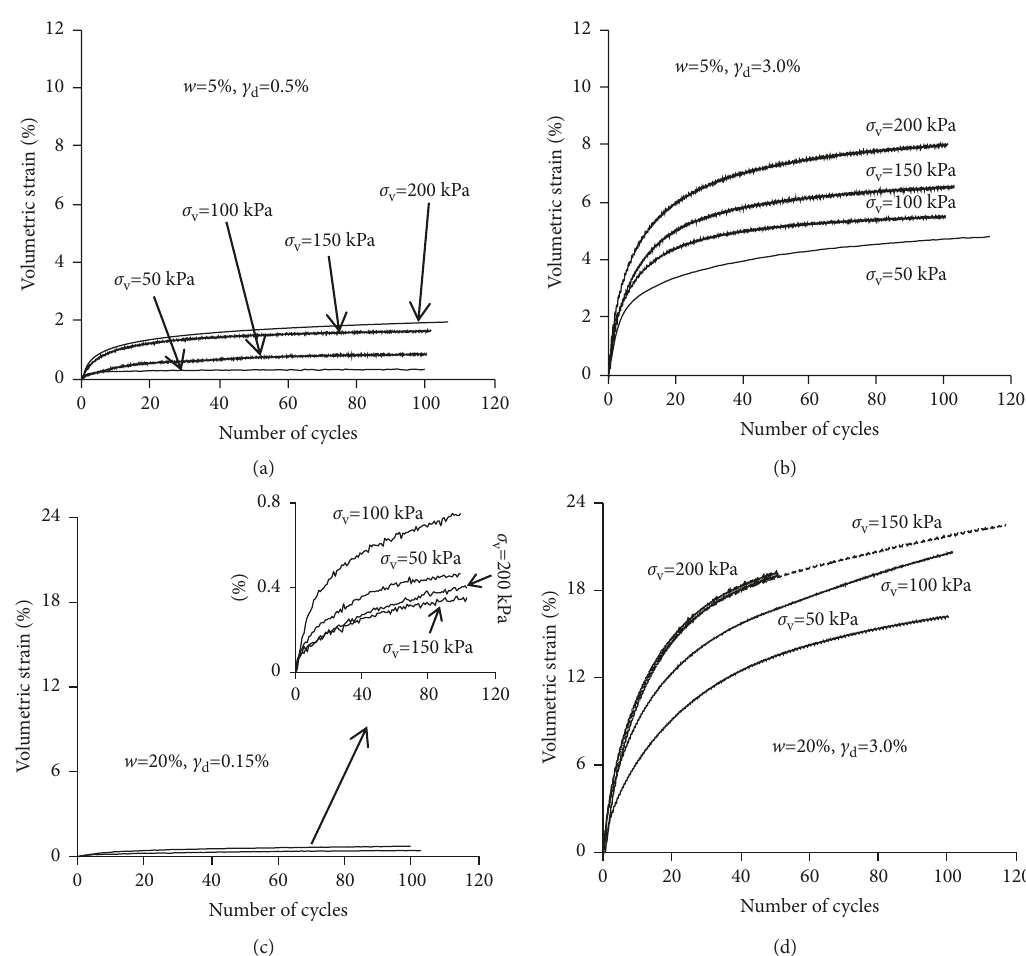
Figure 5: Comparison between the volumetric strain time histories under different vertical stress (here, w is water content, σv is vertical stress, and c d is the amplitude of shear strain).